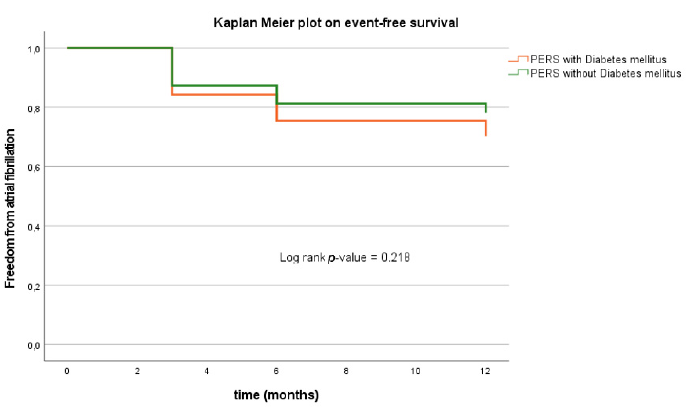
Figure 3. (Representative figure) Kaplan–Meier plot on freedom from AF recurrence in patients undergoing primary PVI due to PAF. AF, atrial fibrillation; PVI, pulmonary vein isolation; PAF, paroxysmal atrial fibrillation; DM, diabetes mellitus; FU, follow-up. A p -value ≤ 0.05, * and bold letters indicate statistical significance.